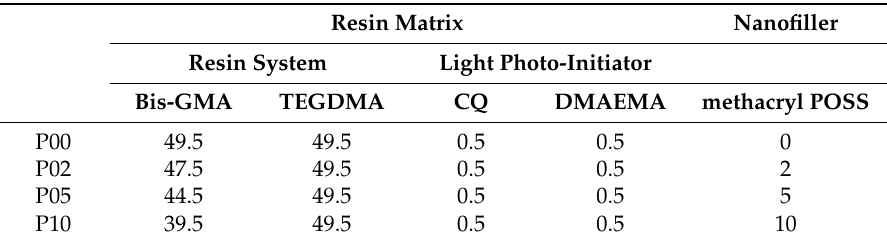
Table 1. The compositions proportion of POSS hybrid dental nanocomposites. Resin Matrix Nanofiller Resin System Light Photo-Initiator